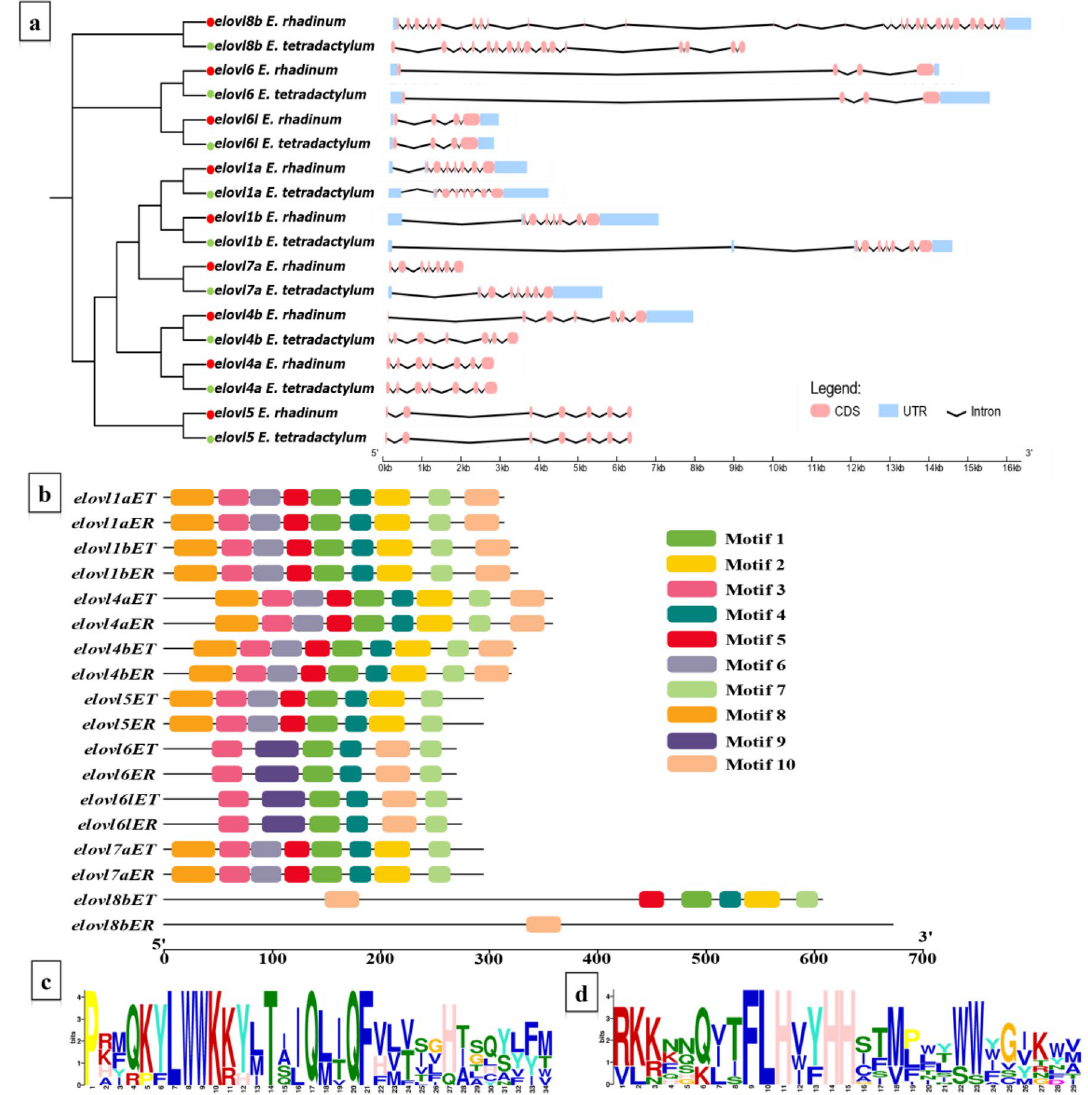
Figure 2. Gene structure and conserved motifs diagram of Elovl genes. ( a ) Gene structure of Elovl genes. Exons were represented by pink boxes and introns by black lines; ( b ) Conserved motifs of Elovl proteins; ( c and d ) Logo representations of the ELO domains, motifs 1 and 2,